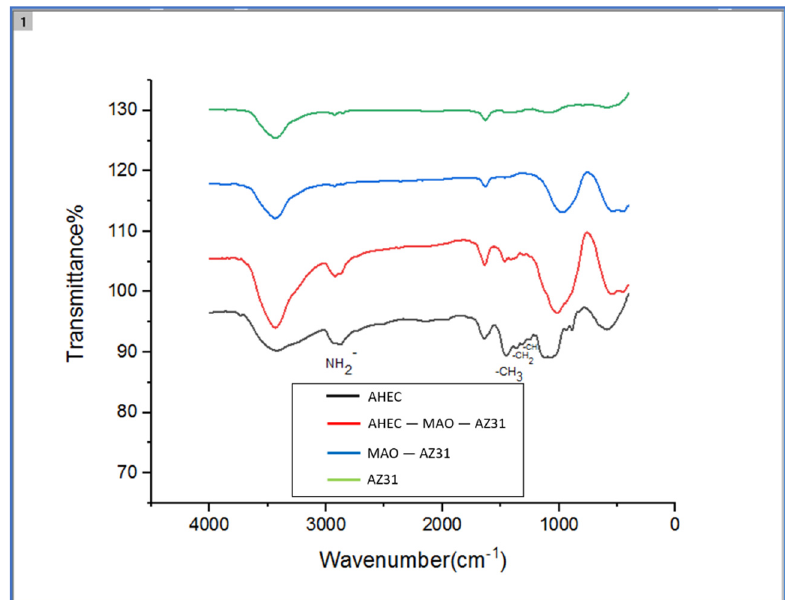
Figure 4. Fourier-transform infrared spectroscopy (FT-IR) spectrum of the AZ31, MAO + AZ31, AHEC + MAO + AZ31, and pure